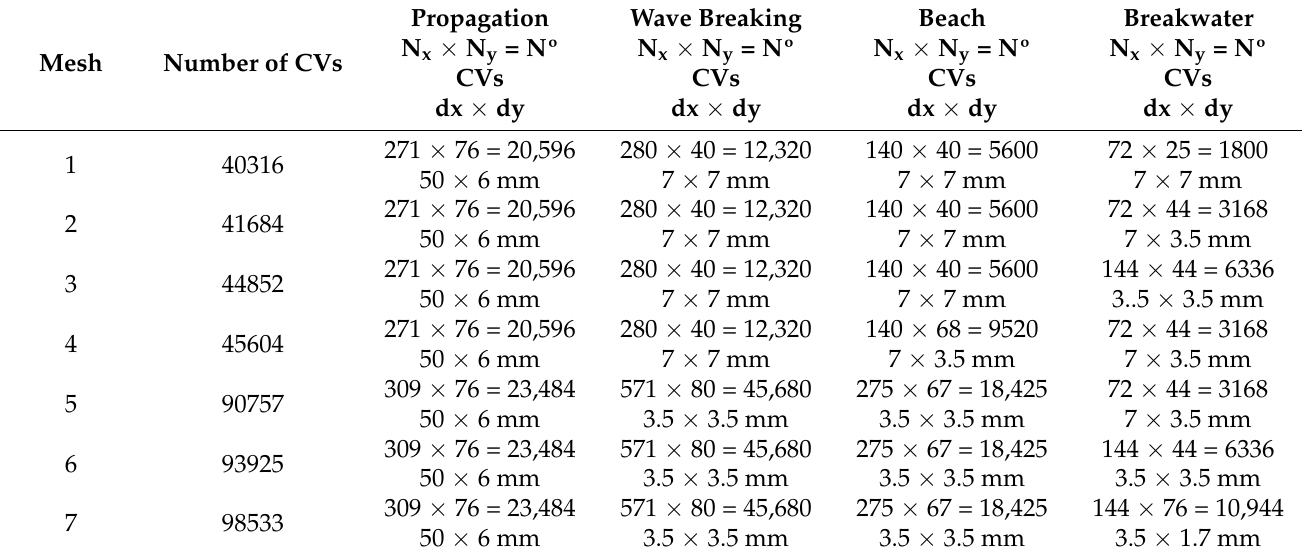
Table 3. Mesh characteristics zone by zone with total number of control volumes and number of control volumes in x and y discretisation used in FLUENT.